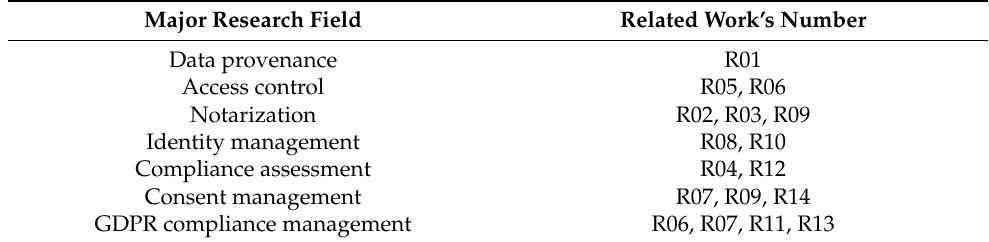
Table 2. Related works by research field.